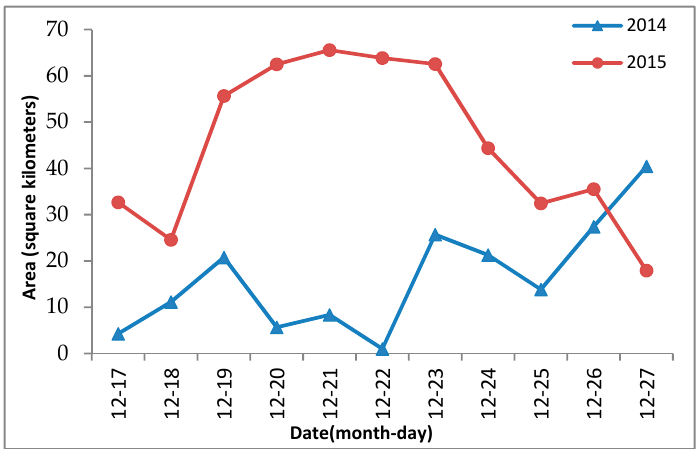
Figure 7. Comparison of daily haze area from 17 December to 27 December between 2015 (haze period) and 2014 (no haze period).